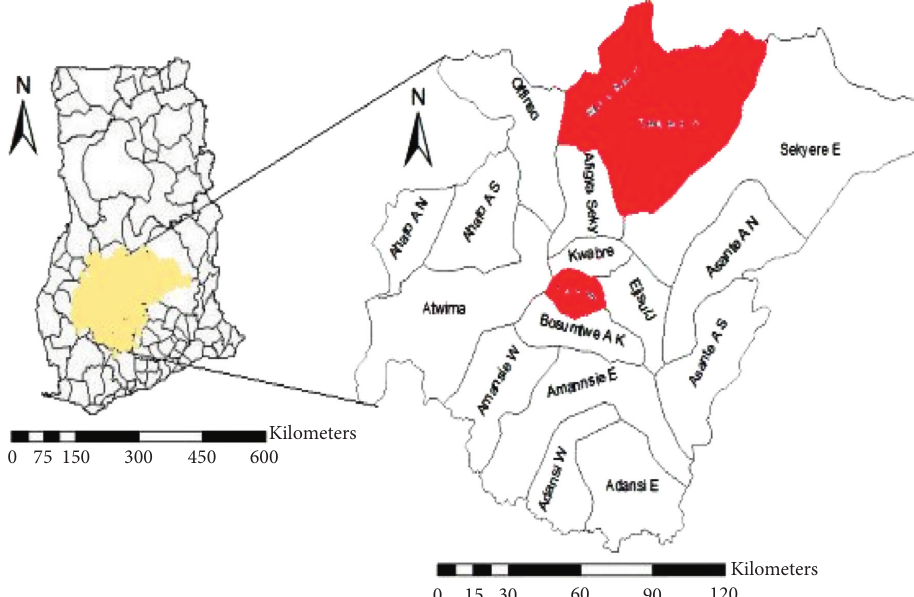
Figure 1: Map of Ashanti region indicating the sampling area (section highlighted in red). Source: adapted from